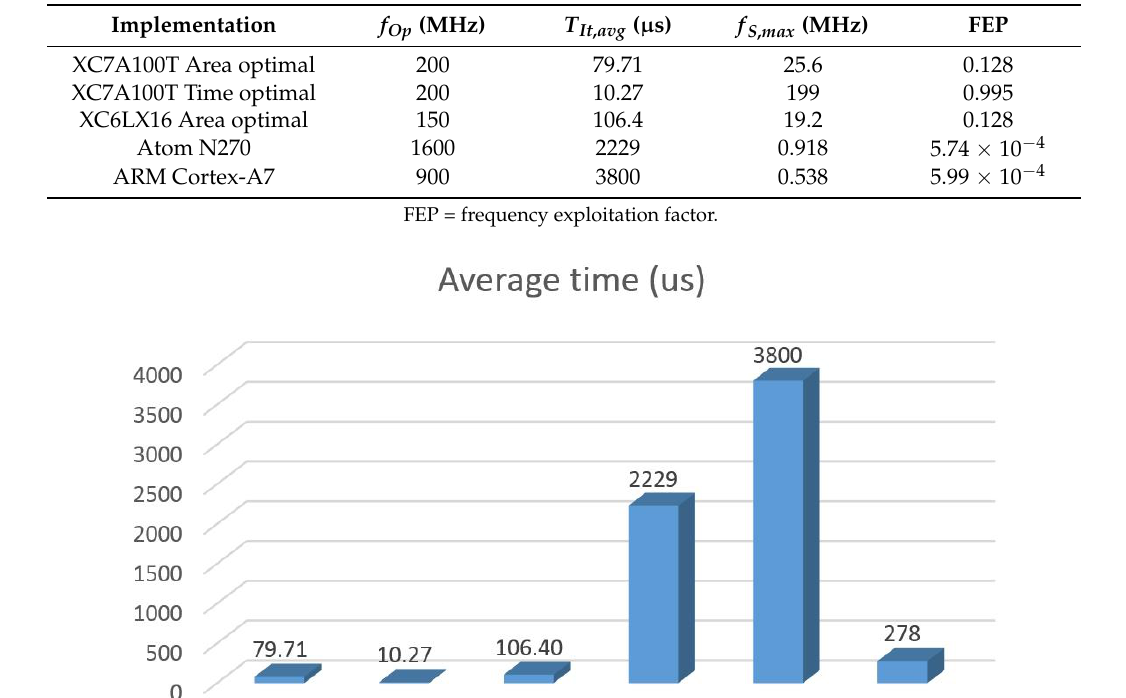
Table 5. Time results summary.